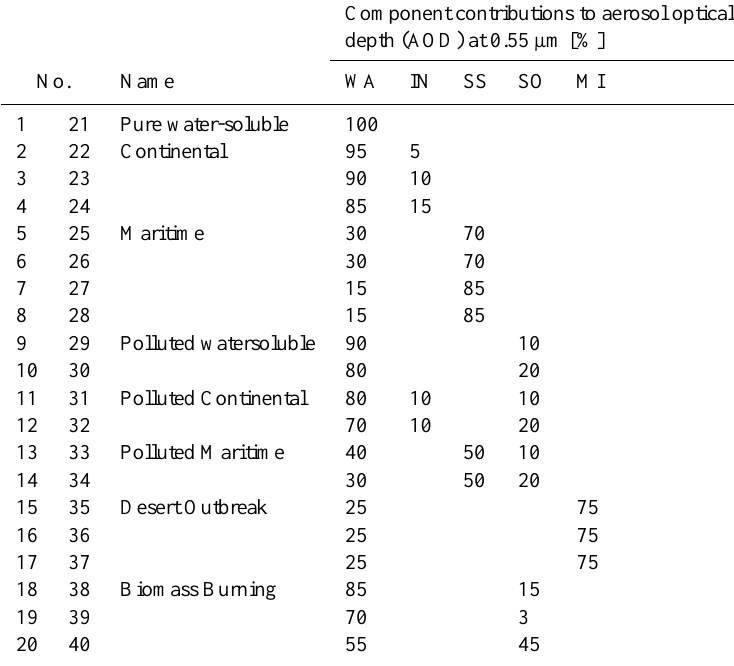
Table 1. Pre-defined external aerosol mixtures of the basic components which are used in SYNAER. Adapted from Holzer-Popp et al. (2008). WA = watersoluble, IN = insoluble, SS = sea salt, SO = soot, MI = mineral dust.